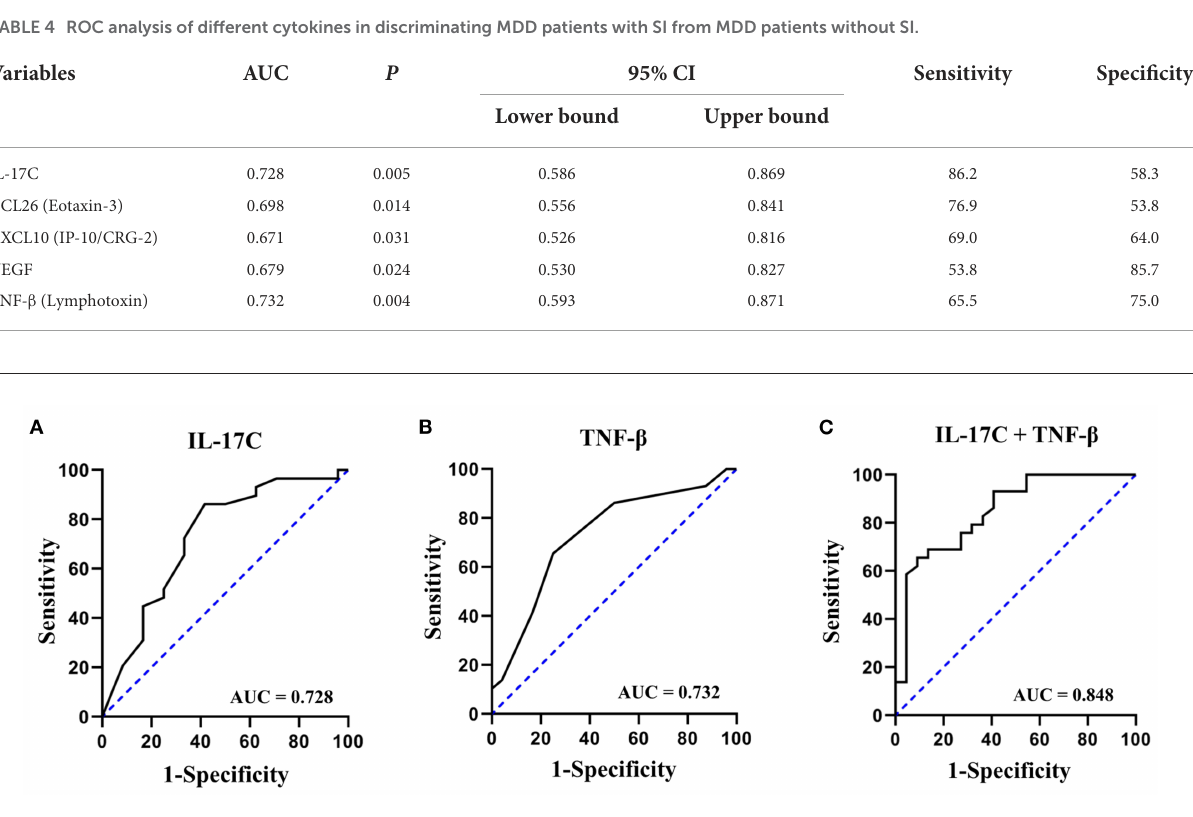
FIGURE1 ROC curves of IL-17C, TNF- β , and a combined panel of IL-17C and TNF- β in discriminating MDD patients with SI from MDD patients without SI. (A) ROC curve of IL-17C; (B) ROC curve of TNF- β ; (C) ROC curve of a combined panel of IL-17C and TNF- β